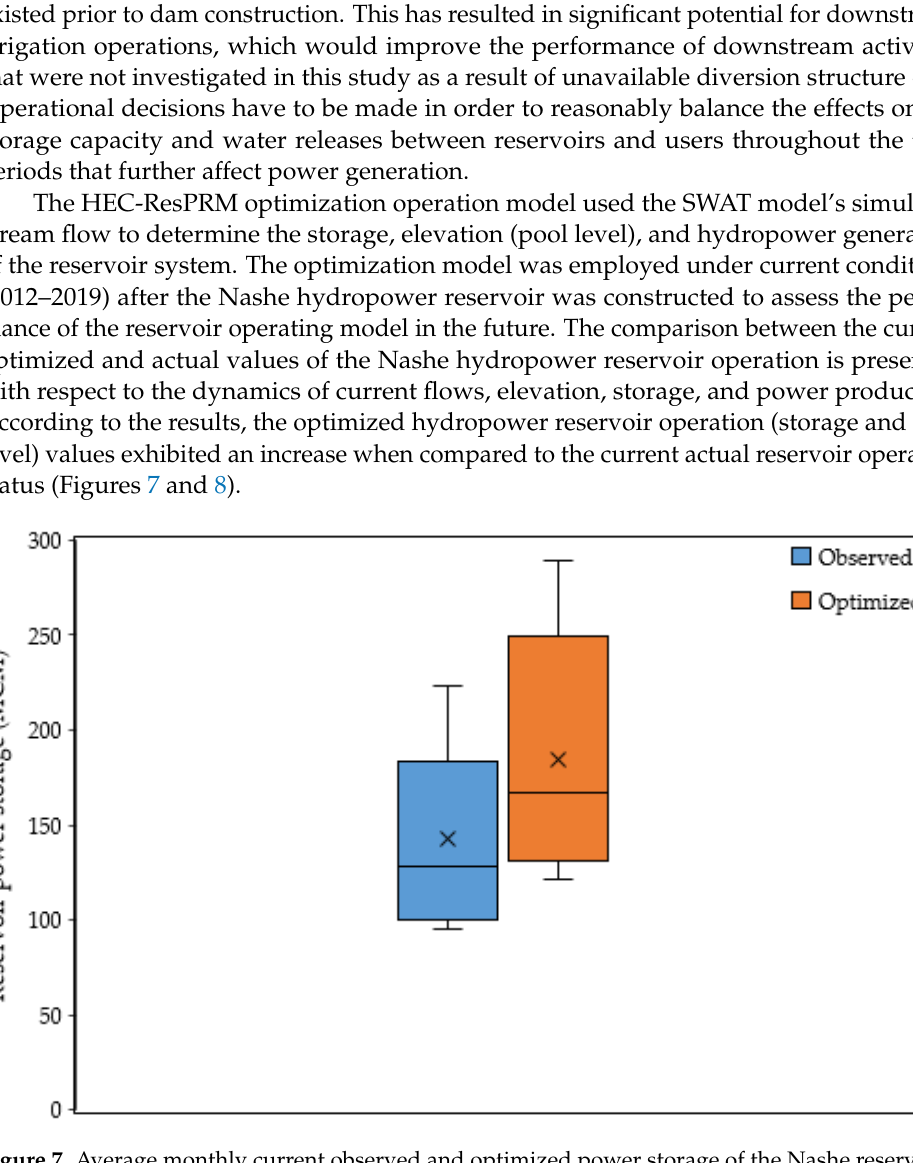
Figure 8. Average monthly current observed and optimized elevation of the Nashe reservoir. The aim of performance measures is to provide a mechanism to compare the effec- tiveness of the reservoir system in accomplishing specific objectives quantitatively for dif- ferent operating plans. In addition to the current reservoir operation, optimization strate- gies for the sole purpose of hydropower generation are frequently used in the area of wa- ter resources management [18]. The average annual optimized reservoir power storage and reservoir pool level increased by 10.58 MCM and 3.12 m, respectively. Figure 9 shows the associated optimal hydropower generation compared to the actual hydropower out- put. As can be seen, optimized operation performs better. Since the total volume passing the turbines is generally the same in both operation scenarios, the add-on for power sup- ply is mainly generated by an increased storage level, and with that, an increased water head.